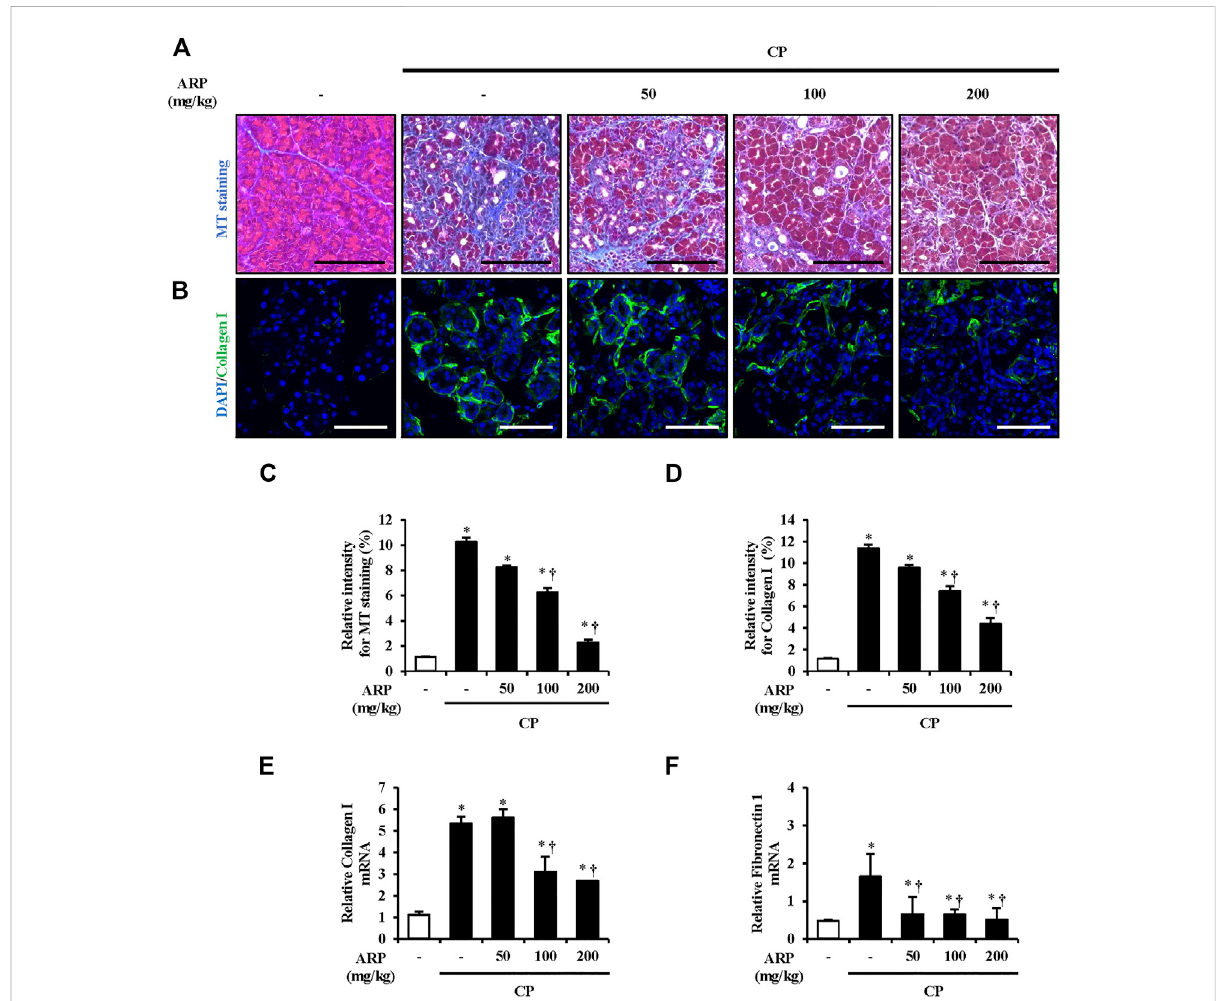
Effect of ARP water extract on ECM deposition during CP. (A) Masson ’ s trichrome staining for collagen deposition in the saline, CP, and ARP groups (50, 100, and 200 mg/kg). (B) Confocal images of immuno fl uorescence staining for collagen I in the saline, CP, and ARP groups; the green color shows collagen I positive cells, and the blue color shows DAPI positive cells. (C) The relative intensity of Masson ’ s trichrome staining. (D) Relative intensity of collagen I. (E) Collagen I mRNA level in the pancreas was assessed using RT-qPCR. (F) Fibronectin one mRNA level in the pancreaswasassessedusingRT-qPCR.Dataarerepresentedasmeans±SEM( n =3pergroup).Resultsarerepresentativeofthreeexperiments.* p < 0.05 vs. saline alone; † p < 0.05 vs. CP. Original magni fi cation, ×400. Scale bar = 50 μ